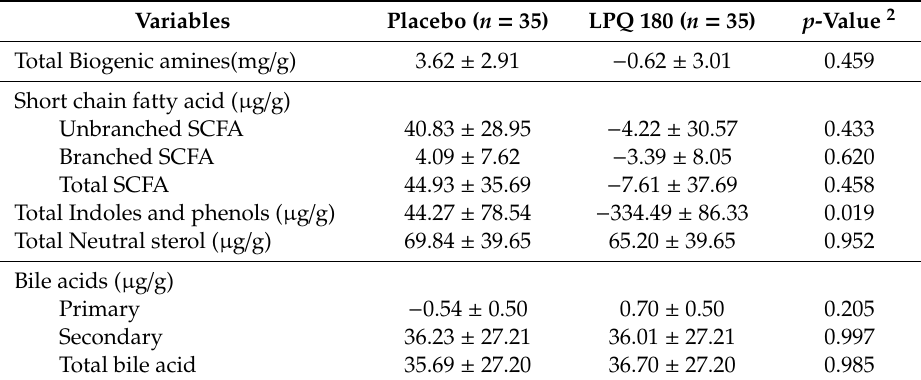
Table 3. Comparison of intestinal microbial metabolites in feces for 12 weeks 1